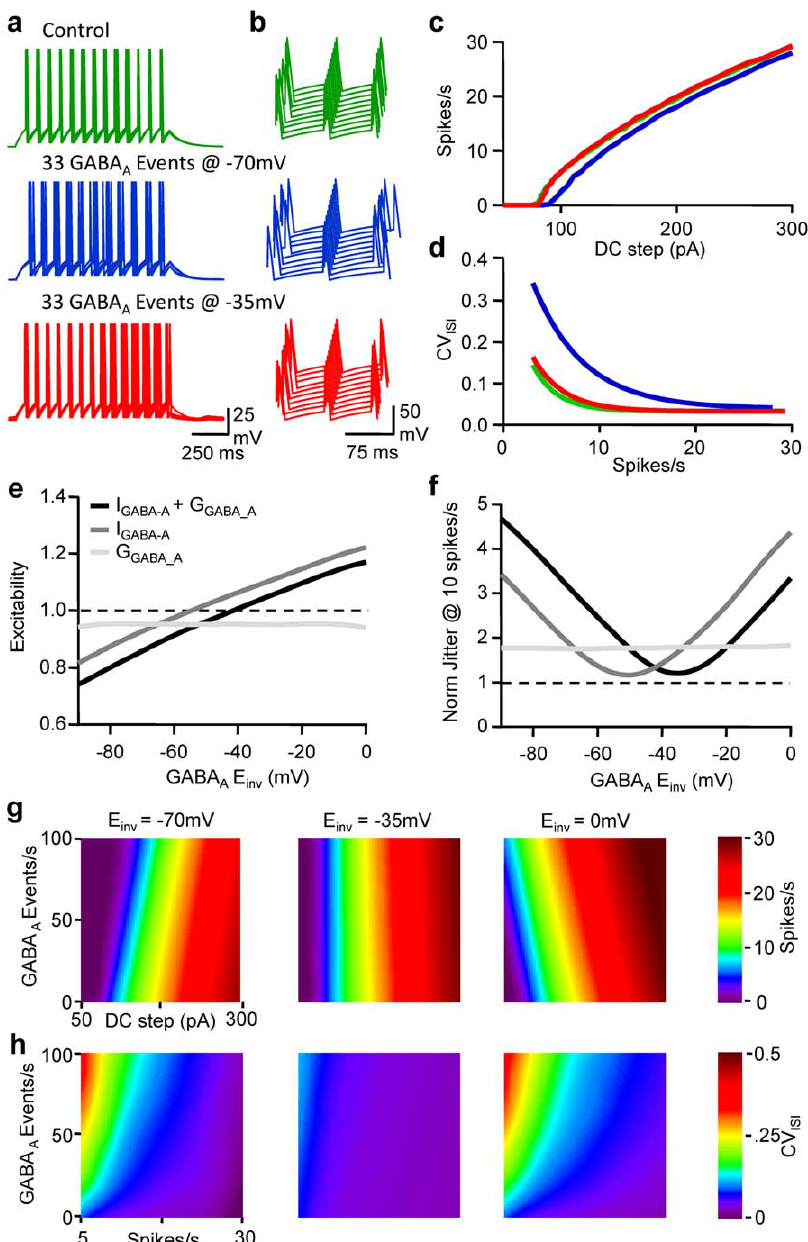
Figure 7. Frequency and reversal potential-dependent tuning of pyramidal cell excitability and discharge fidelity. a, Superimposed (5) Vm fluctuations of the LIF model in response to a DC step (1 s, 160 pA) in control conditions (green), when the LIF model received 33 randomly occurring GABA A events/s at E GABA = 2 70 mV (blue) or 2 35 mV (red). Same colour code for b, c and d. b, Waterfall view of Vm when the 5 th spike was set as the time reference. c, Mean firing rate vs DC step. d, CV ISI vs firing rate. e, Normalised changes in excitability observed when LIF model received 33 randomly occurring GABA A events/s at various E GABA in control conditions (black), when GABA activity induced only transient changes in I GABA-A (gray) or when GABA activity induced only transient changes in R in (light gray). f, Normalised changes in spike jitter observed for a rate of 10 spikes/s. Same conditions as in e. g, From left to right firing rate displayed on a pseudocolor scale vs DC step and E GABA when the LIF model received 33 randomly occurring GABA A events/s in control conditions (left), when GABA A activity induced only transient changes in I GABA-A (middle) or when GABA activity induced only transient changes in R in (right). h, CV ISI displayed on a pseudocolor scale vs firing rate and E GABA . Same conditions as in g.